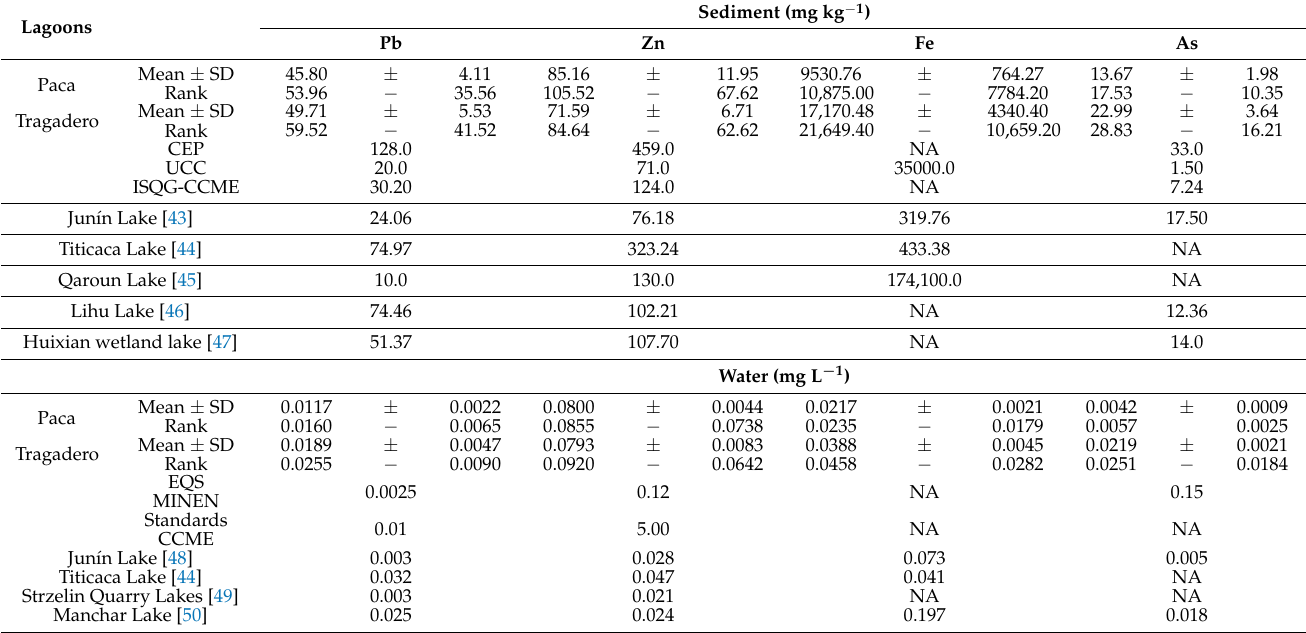
Table 1. Comparison of the mean concentration of heavy metals in the sediment and water of the Paca and Tragadero lagoons in this study with threshold values, background values, quality guidelines, and mean concentrations of other lagoons.